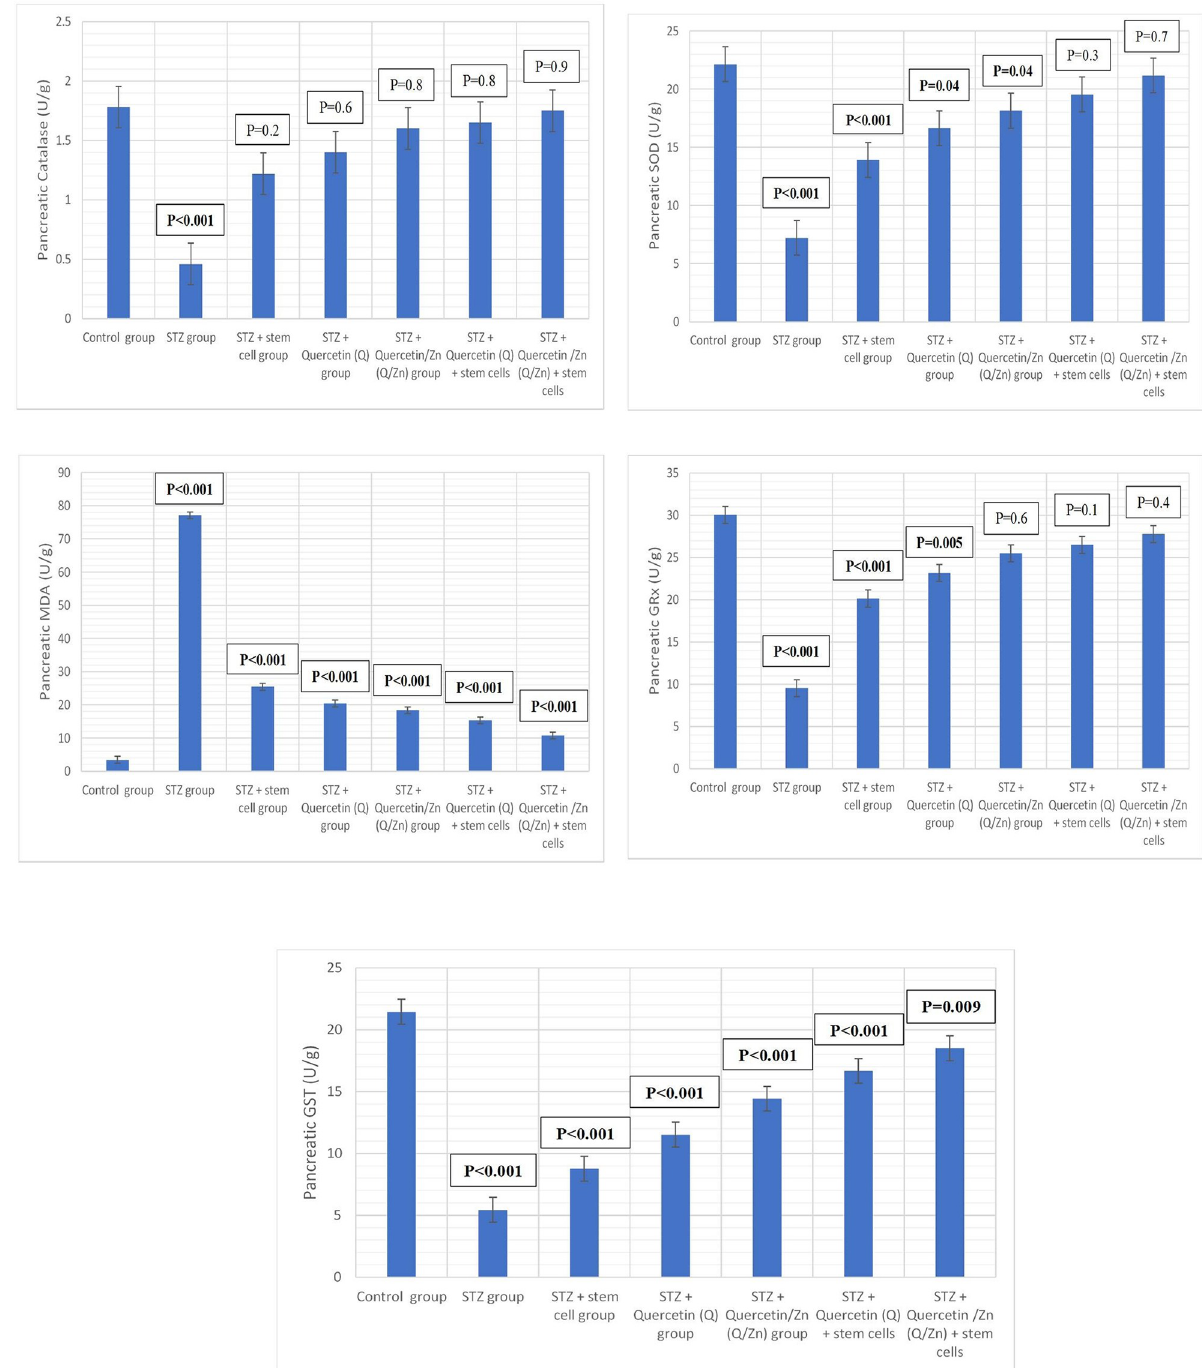
Fig 10. Antioxidant enzymes markers in pancreatic tissues (P value mentioned). Where, P-value � 0.05 was considered significant. P-value < 0.001 was considered highly significant. P-value > 0.05 was considered non-significant.